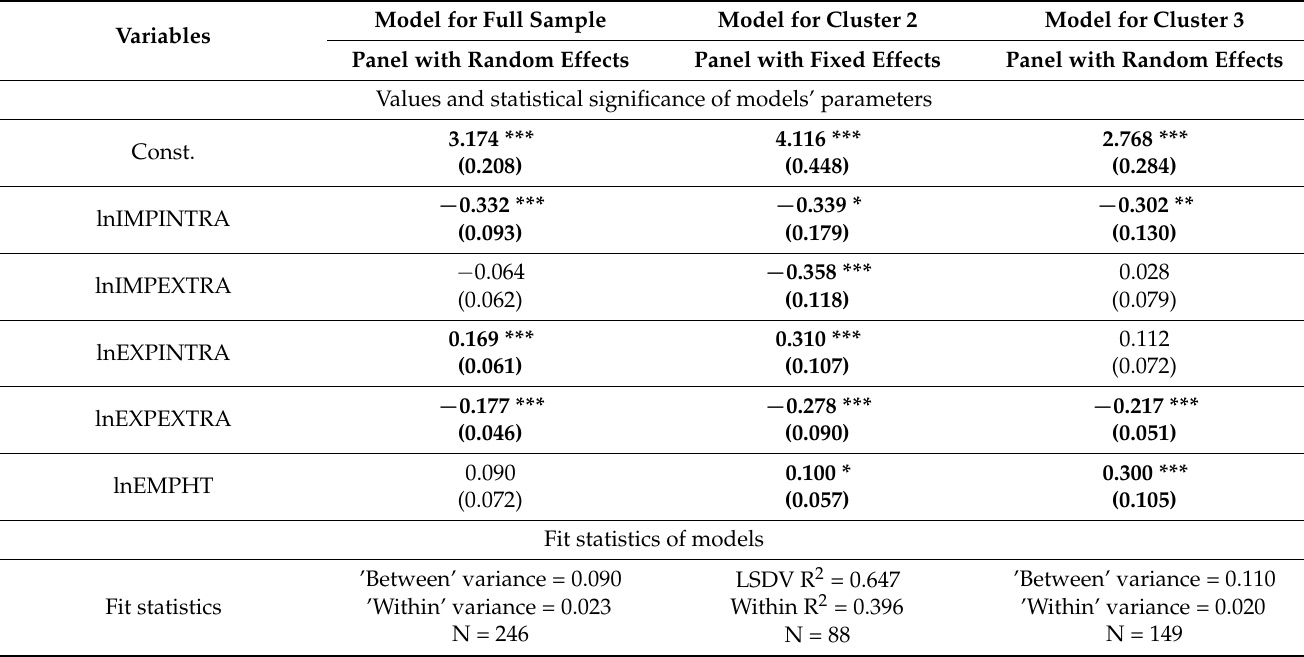
Table 6. Results of panel model estimations for start-up rates as dependent variable (lnSR). Variables